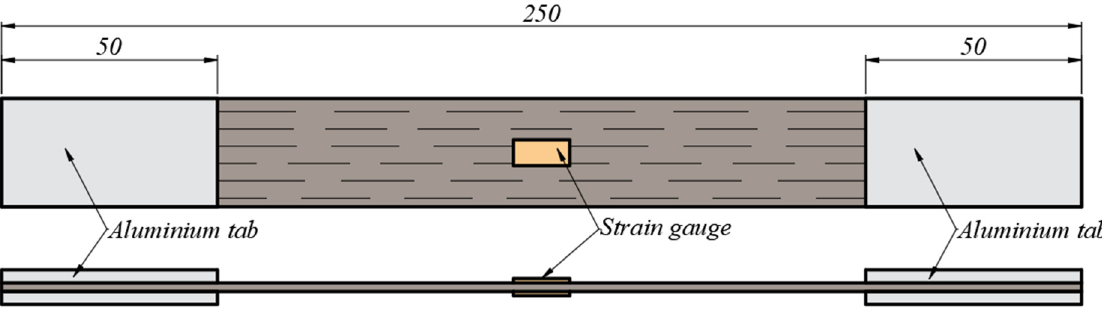
Figure 1. Sample equipped with tabs and strain